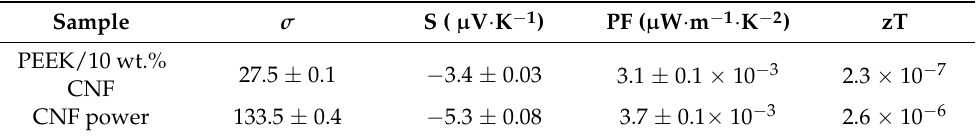
Figure 6. Electrical volume conductivity (black icons) and Seebeck coefficient (red icons) of CNF powder (circle icons) and PEEK/10 wt.% CNF composite (triangle icons). The black and red dash lines represent the fitting with Equations (2) and (3), respectively. Table 2. Electrical conductivity σ , Seebeck coefficient S, power factor PF, and figure of merit zT of PEEK/10 wt.% CNF composites and CNF powder at 30 ◦